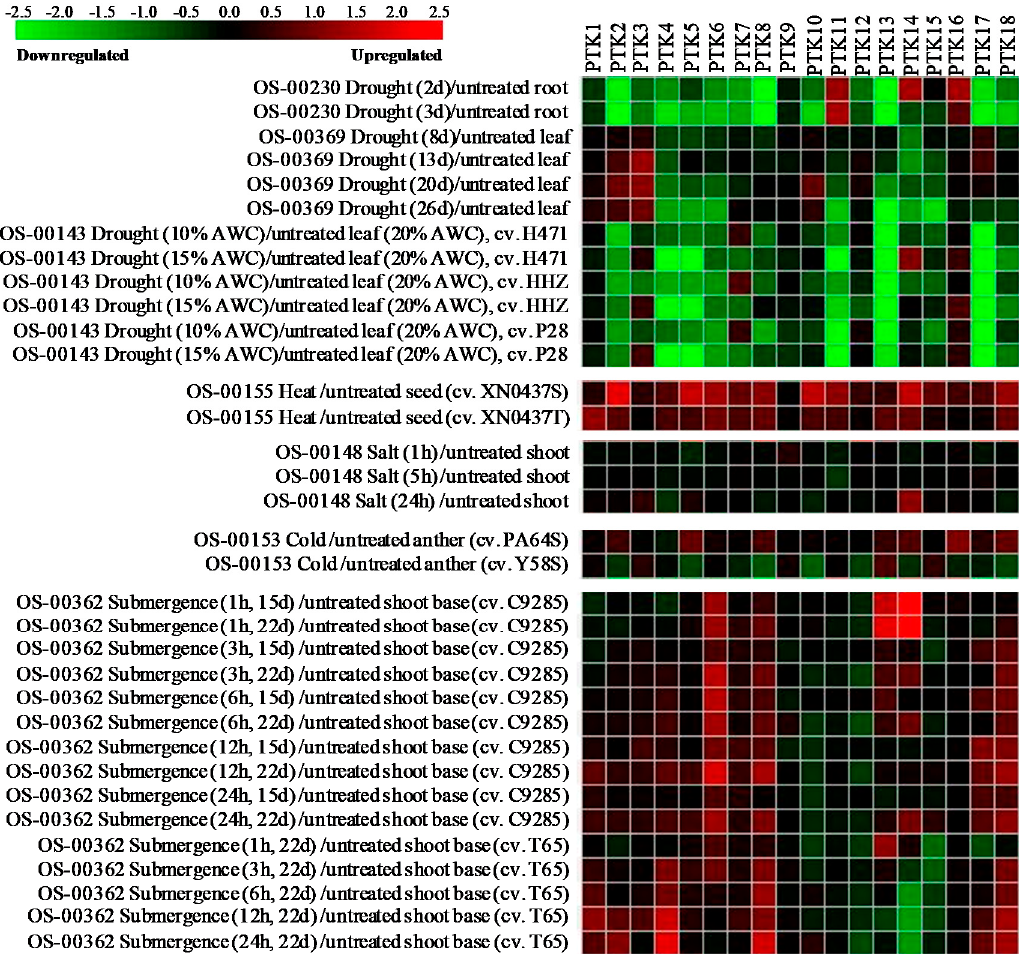
Figure 6. Expression analysis of PTK genes under di ff erent abiotic stress conditions in rice. Expression analysis was carried out with mRNAseq datasets using Genevestigator.